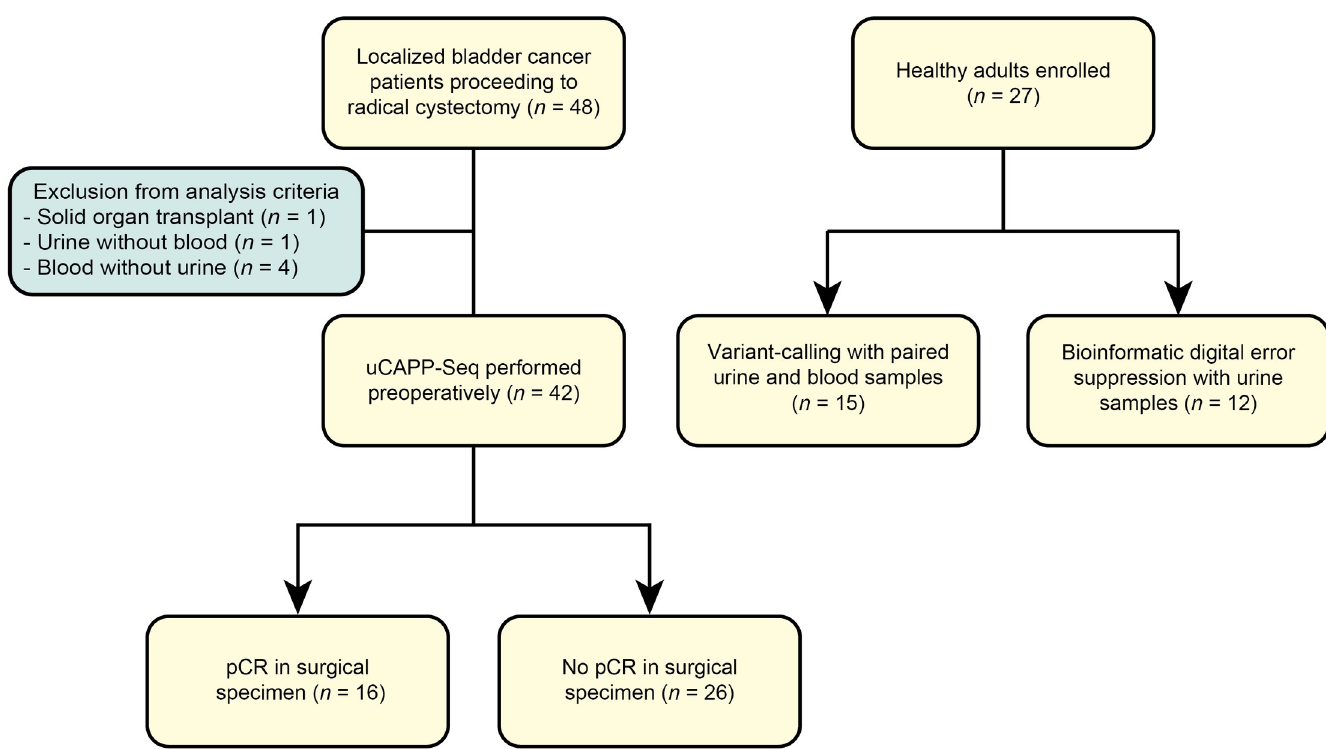
Fig 1. Patient enrollment and sample collection for utDNA MRD analysis. Patients with localized bladder cancer who were candidates for radical cystectomy were enrolled onto this study, as were healthy adult donors. Biofluid samples were then collected for utDNA analysis as shown in the schema. MRD, minimal residual disease; pCR, pathologic complete response; uCAPP-Seq, urine Cancer Personalized Profiling by Deep Sequencing; utDNA, urine tumor DNA.